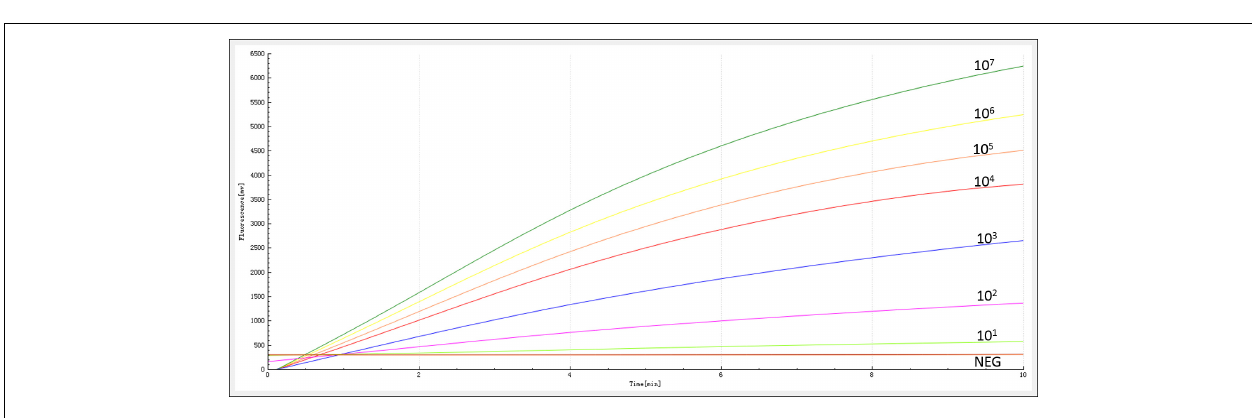
FIGURE 3 | Sensitivity of the RAA assay. An increase in the fluorescence signal was observed from 1 × 10 7 to 1 × 10 1